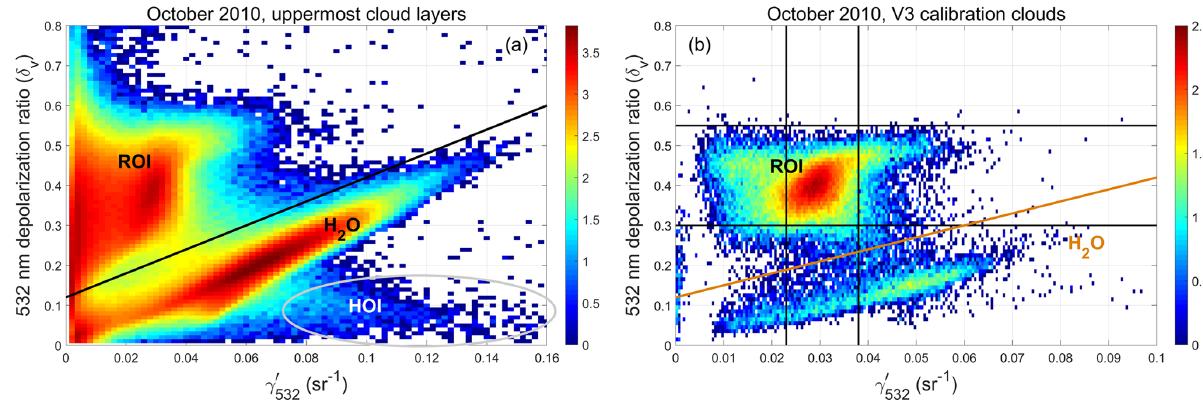
Figure 11. Panel (a) shows the joint occurrence frequency of δ v and γ (cid:48) for clouds measured by CALIOP during October 2010. Only layers 532 detected at 5km horizontal resolution that are the uppermost layer in each profile are included. The solid black line differentiates randomly oriented ice clouds (above the line) from water clouds (below the line). Clouds containing horizontally oriented ice crystals occur within the oval at the bottom of the plot. Panel (b) shows the joint occurrence frequency of δ v and γ (cid:48) for clouds used in the V3 1064nm calibration 532 analysis. The population of points below the orange threshold line quantifies the occurrence frequency of water clouds in the October 2010 V3 calibration data set. In both plots, the colors indicate log 10 of the number of samples in each grid cell.